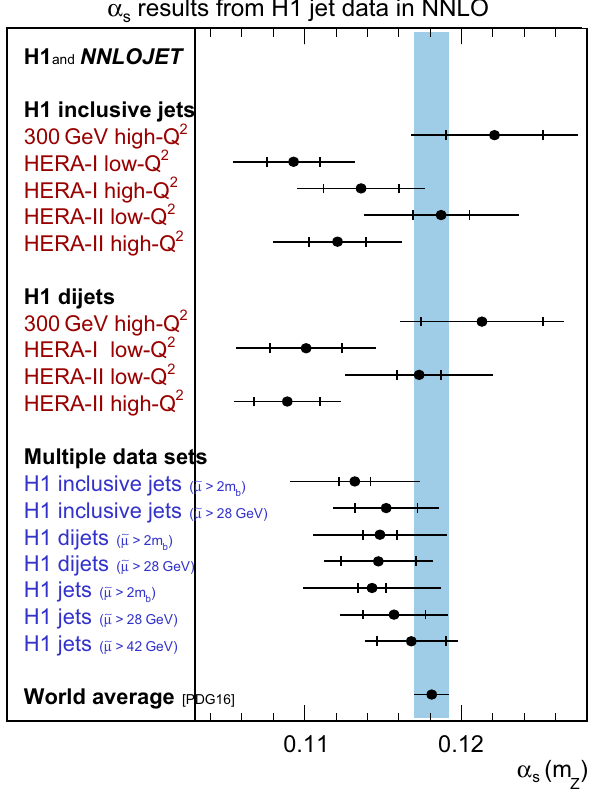
Fig. 11 Summaryof α s ( m Z ) valuesobtainedfromfitstoindividualand multiple H1 jet data sets. The inner error bars indicate the experimental uncertainty and the outer error bars the total